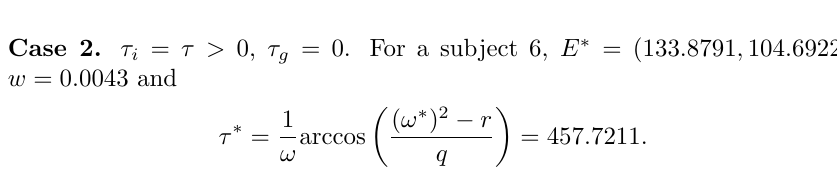
Figure 3. Glucose-insulin dynamics: dynamics and phase plain for τ = 500 > τ ∗ = 457